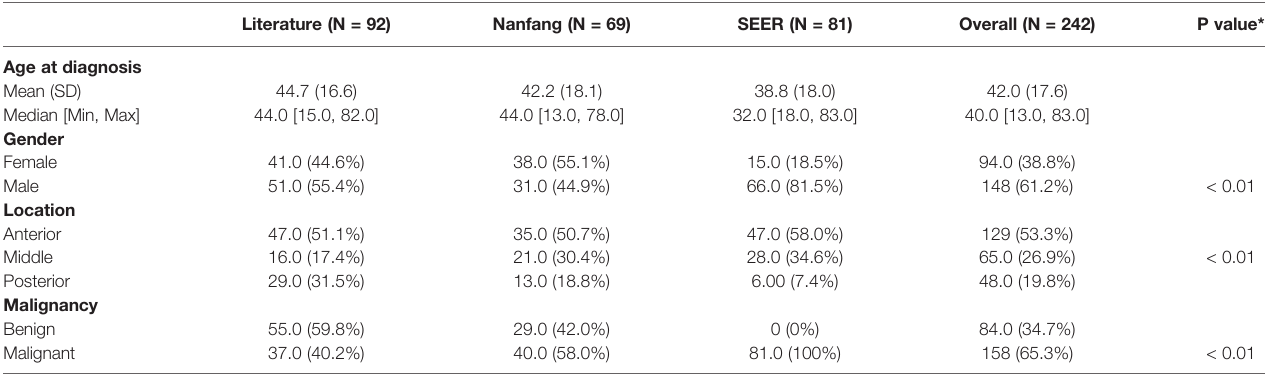
TABLE 1 | Clinical features of the resected GMTs by